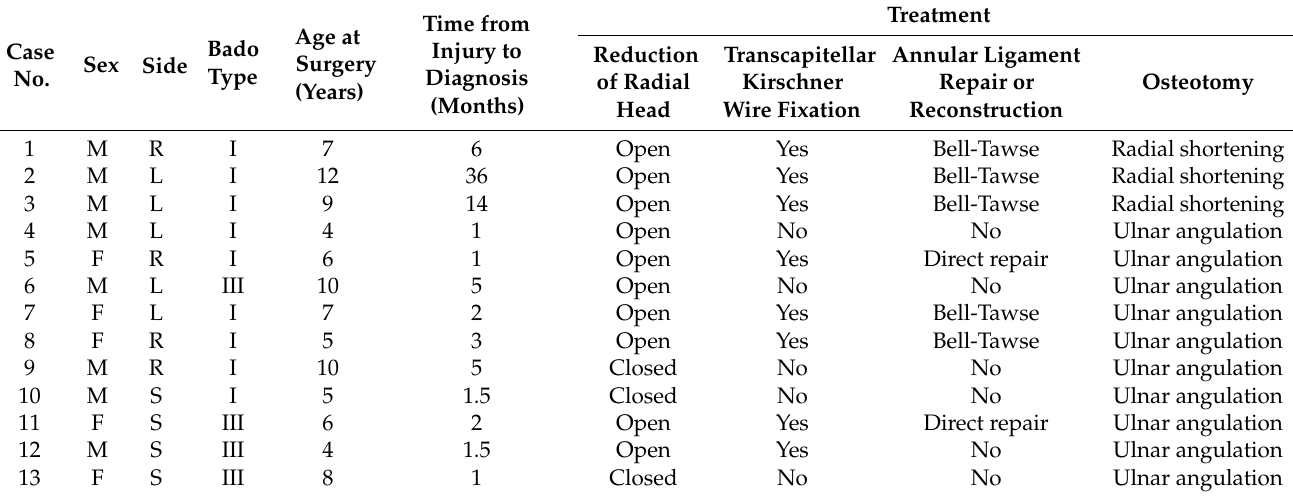
Table 1. Patients’ demographics and treatment overview.